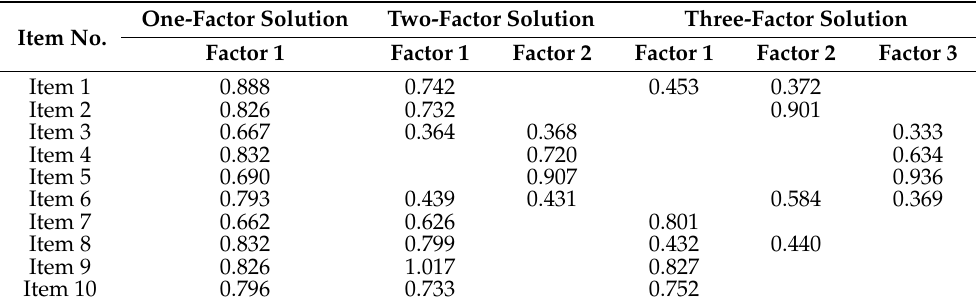
Table 4. Factor matrix for the EPDS in the T2 Slovak sample (exploratory factor analysis with oblimin